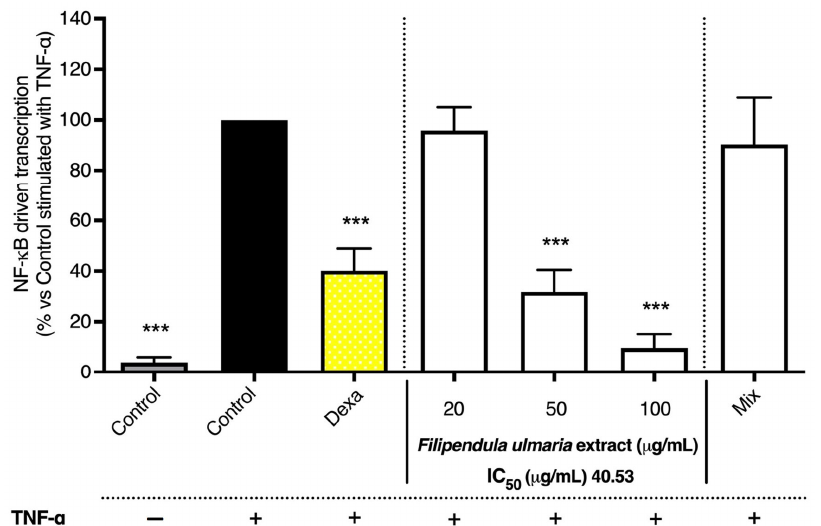
Figure 12. The e ff ect of the F. ulmaria extract and the mix (20 µM of gallic acid and salicylic acid, 6 µM of quercetin and 4 µM of syringic acid) on NF- κ B-driven transcription in L929 cells. Dexame- thasone (Dexa, 1 µM), in yellow, served as positive control. The graph depicts compiled data of three independent experiments (mean ± SD). p -values are expressed as *** p < 0.0001 compared to control stimulated with TNF- α .